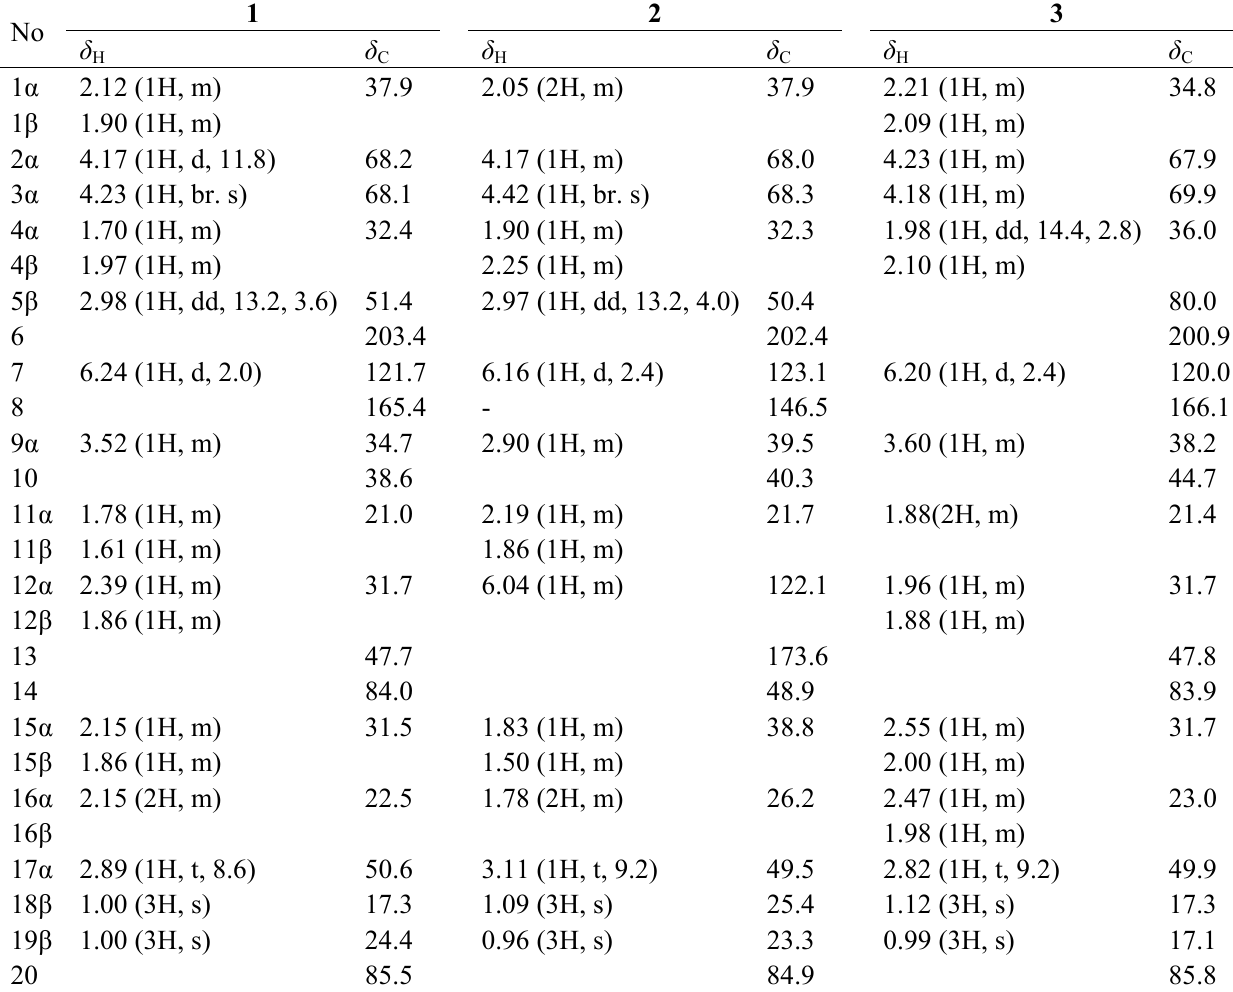
D N. ( δ in ppm, J in 5 5